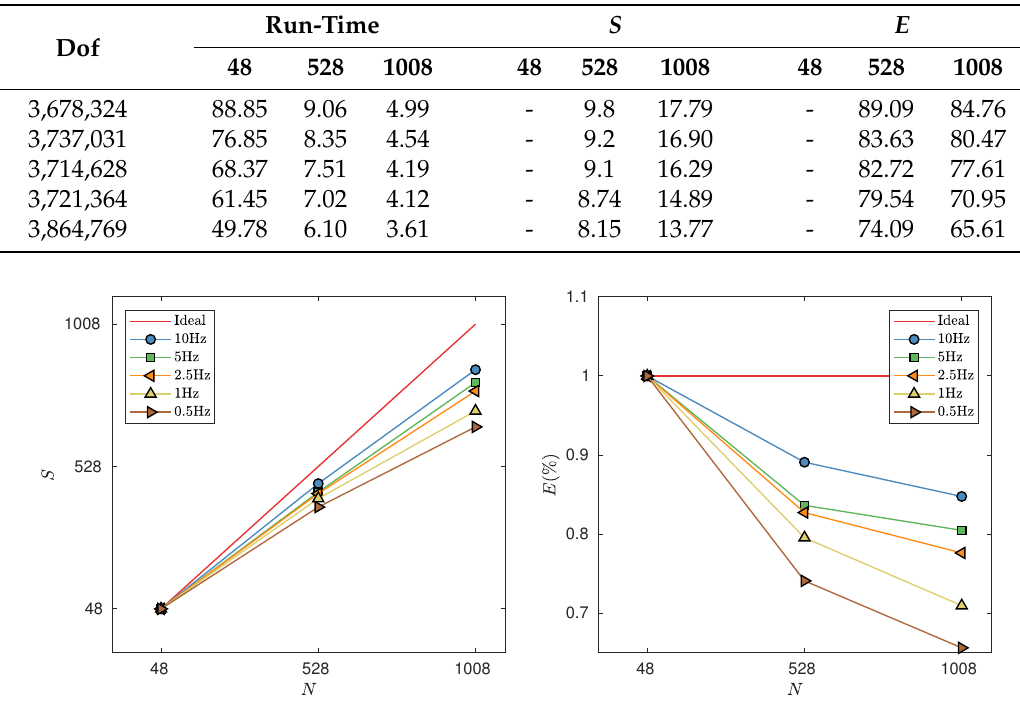
Figure 7. Performance results for the 3D-VTI-B model. For each fundamental frequency, the number of CPU N is plotted versus speed-up S ( left -panel) and parallel efficiency ratio E ( right -panel). The solid red line shows the theoretical ideal performance supposing 100% parallel